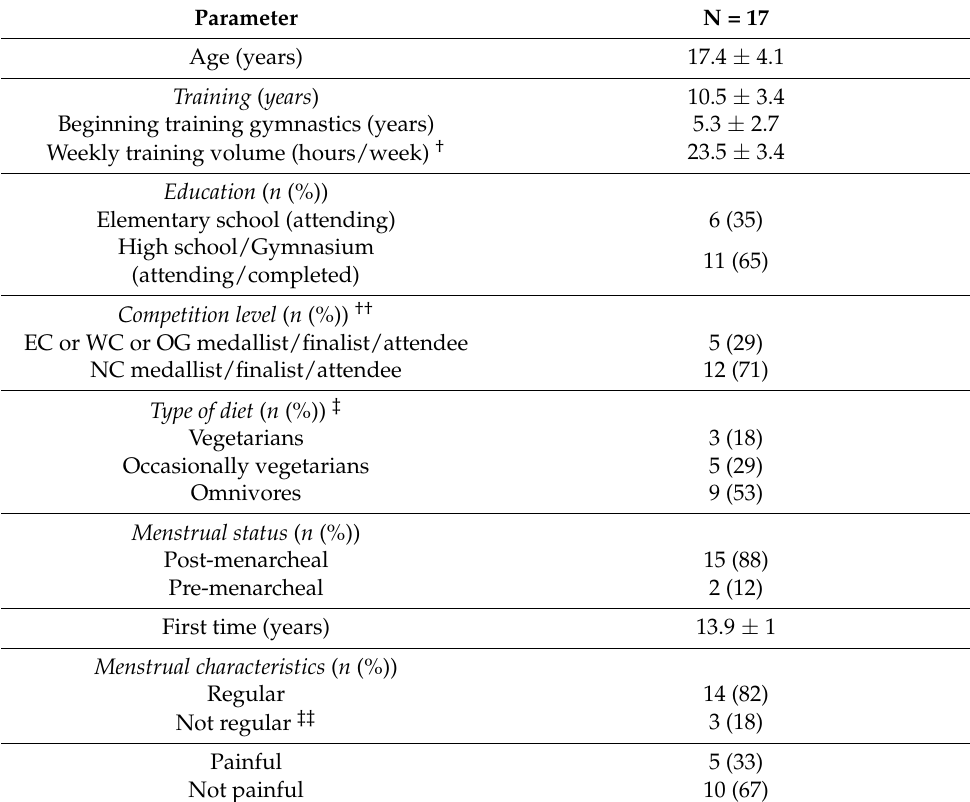
Table 1. Characteristics of the study participants (mean ±